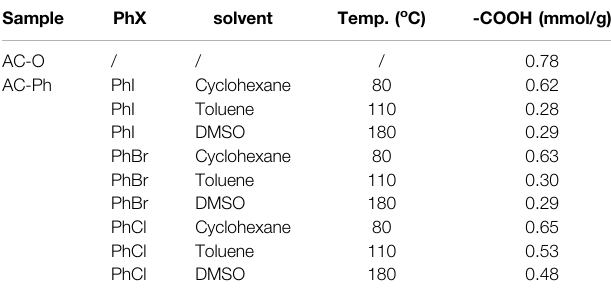
TABLE 1 | Density of -COOH in AC-Ph modi fi ed with different halogenated